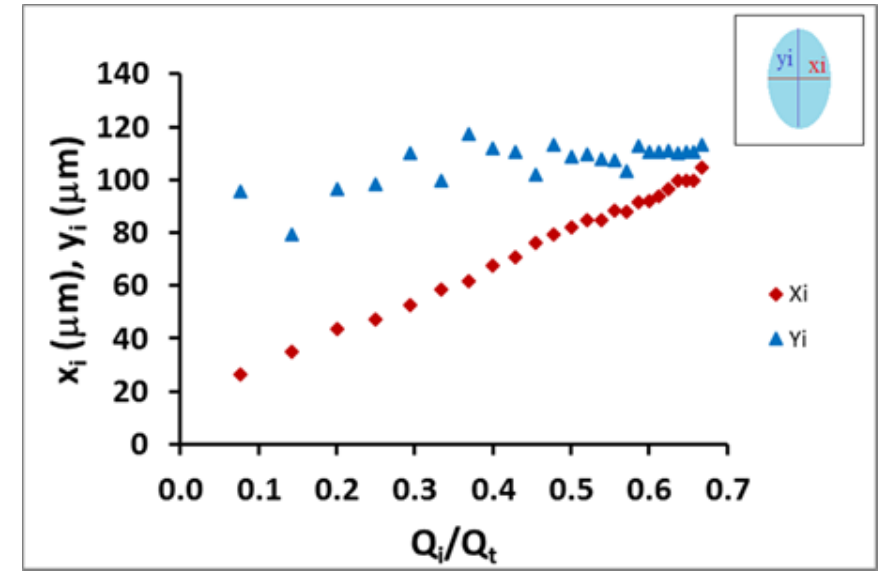
Figure 5. Plots of the behavior of the minor axis of the coaxial ellipse jet ( x i ) and major axis ( y i ) versus the flow rate ratio ( Q int / Q t where Q t = Q int + Q ext ), shown as blue triangles and red diamonds respectively. The growth of both axes is not the same as the flow rate ratio is increased. The aspect ratio x i / y i of the inner flow varies by controlling Q int for a fixed Q ext . It is possible to change from an ellipse cross-section to a circle by increasing Q int .